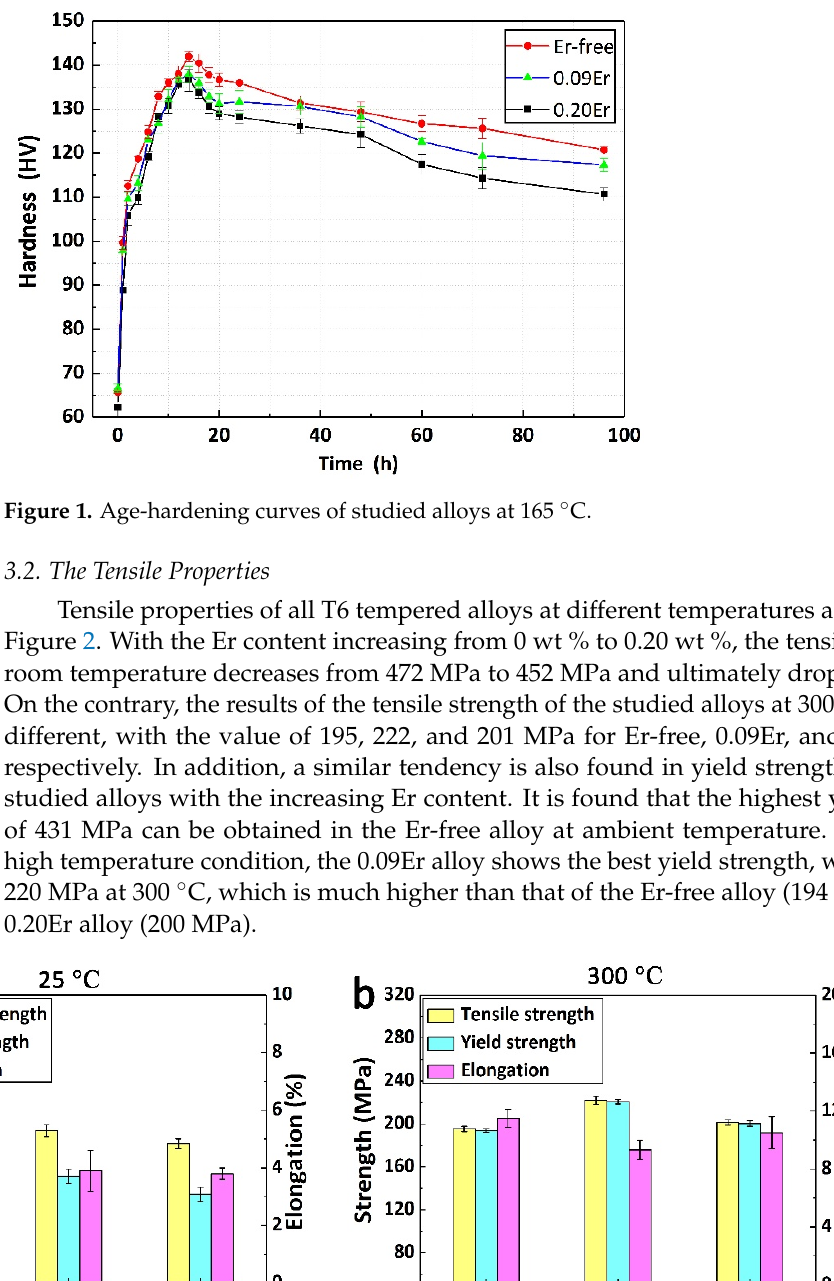
Figure 1. Age-hardening curves of studied alloys at 165 °C.